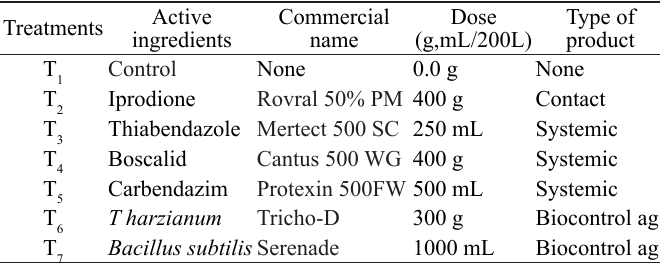
Table 2. Treatments for the control of Sclerotium cepivorum on field for both experimental field